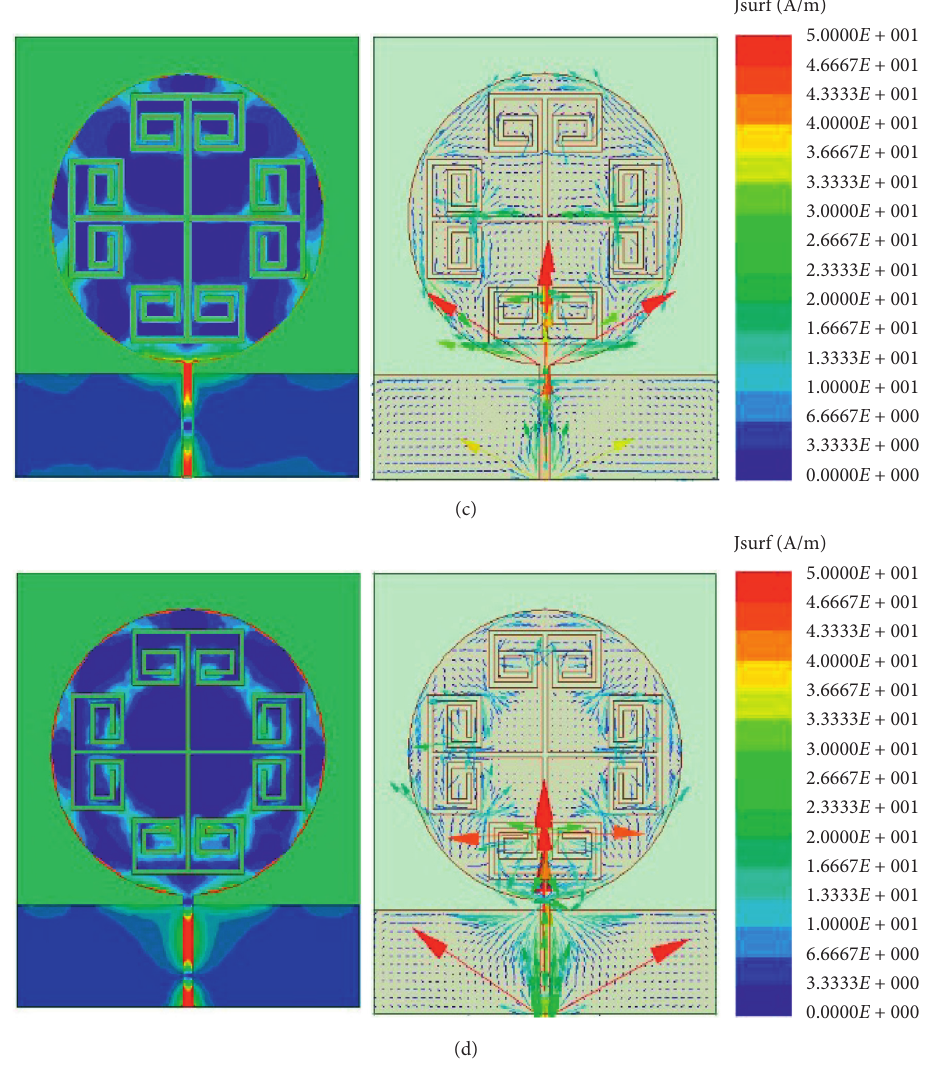
Figure 9: Current amplitude and vector distribution of the antenna at (a) 1.6GHz, (b) 2.35GHz, (c) 3.8GHz, and (d)